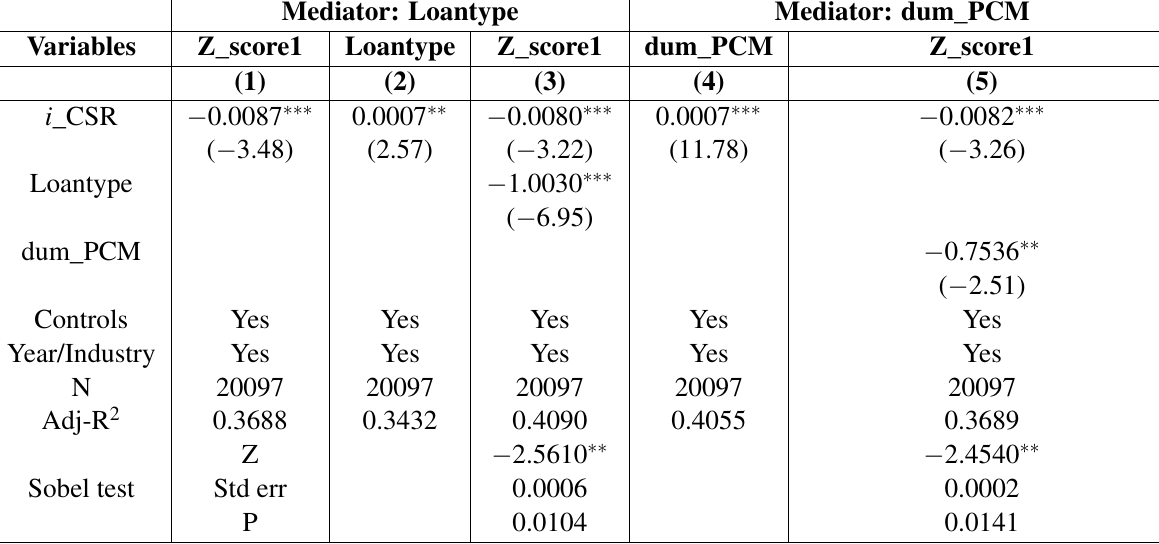
Table 4 Robustness test after replace explanatory variables, mediation variables and explained